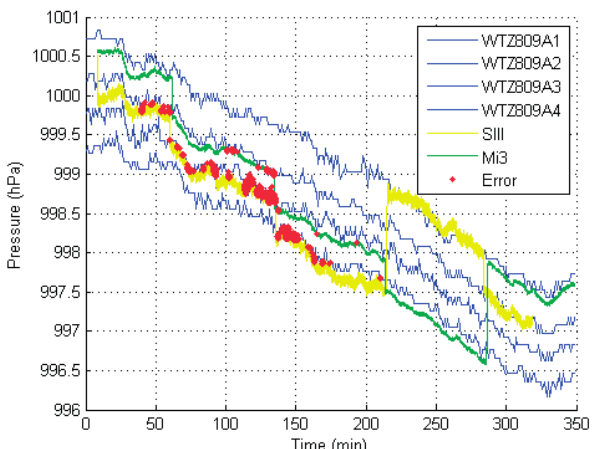
Figure 9. Experimental result in the office building (using a 1-s time window).